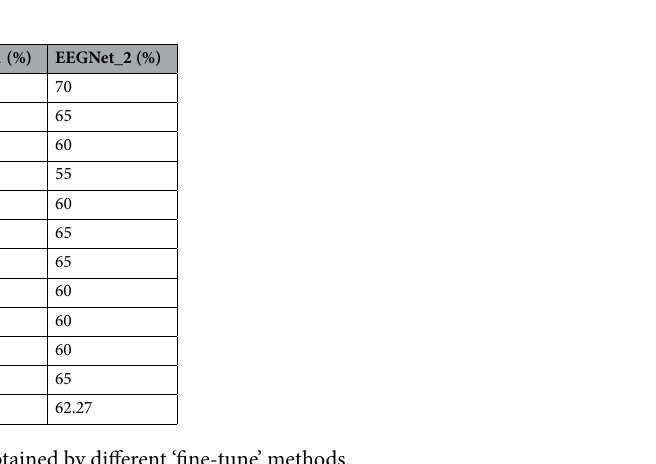
Table 4. Classification results obtained by different ‘fine-tune’